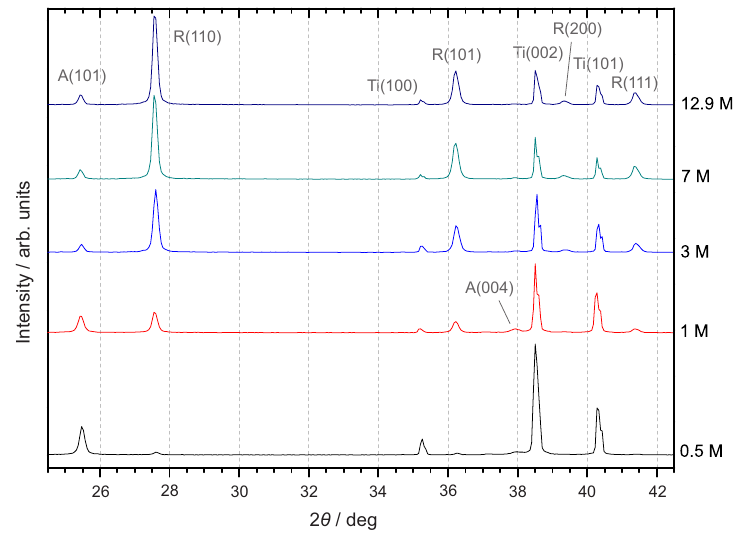
Figure 3. X-ray diffractograms from 24.5 ◦ to 42.5 ◦ (2 θ ) of samples produced with different H 2 SO 4 concentrations. Labeled reflections are assigned to α -Ti, TiO 2 rutile and TiO 2 anatase. Most prominent features of the TiO 2 crystallographic phases are the (101) reflection for anatase (2 θ = 25.46 ◦ ) and the (110) reflection for rutile (2 θ = 27.59 ◦